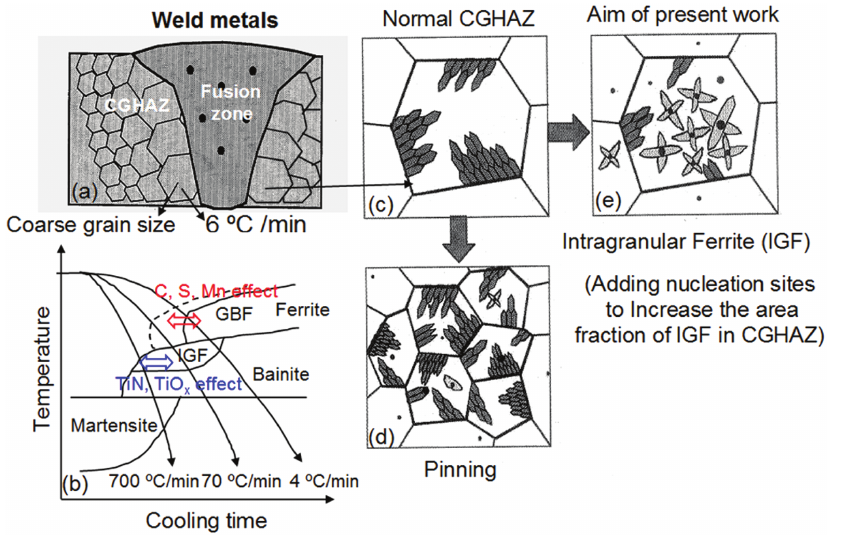
Figure 1: Schematic illustrations of (a) coarse grain heat affected zone (CGHZA), (b) CCT diagram, (c) GBF for- mation in CGHAZ, (d) pinning effect in CGHAZ and (e) IGF formation in